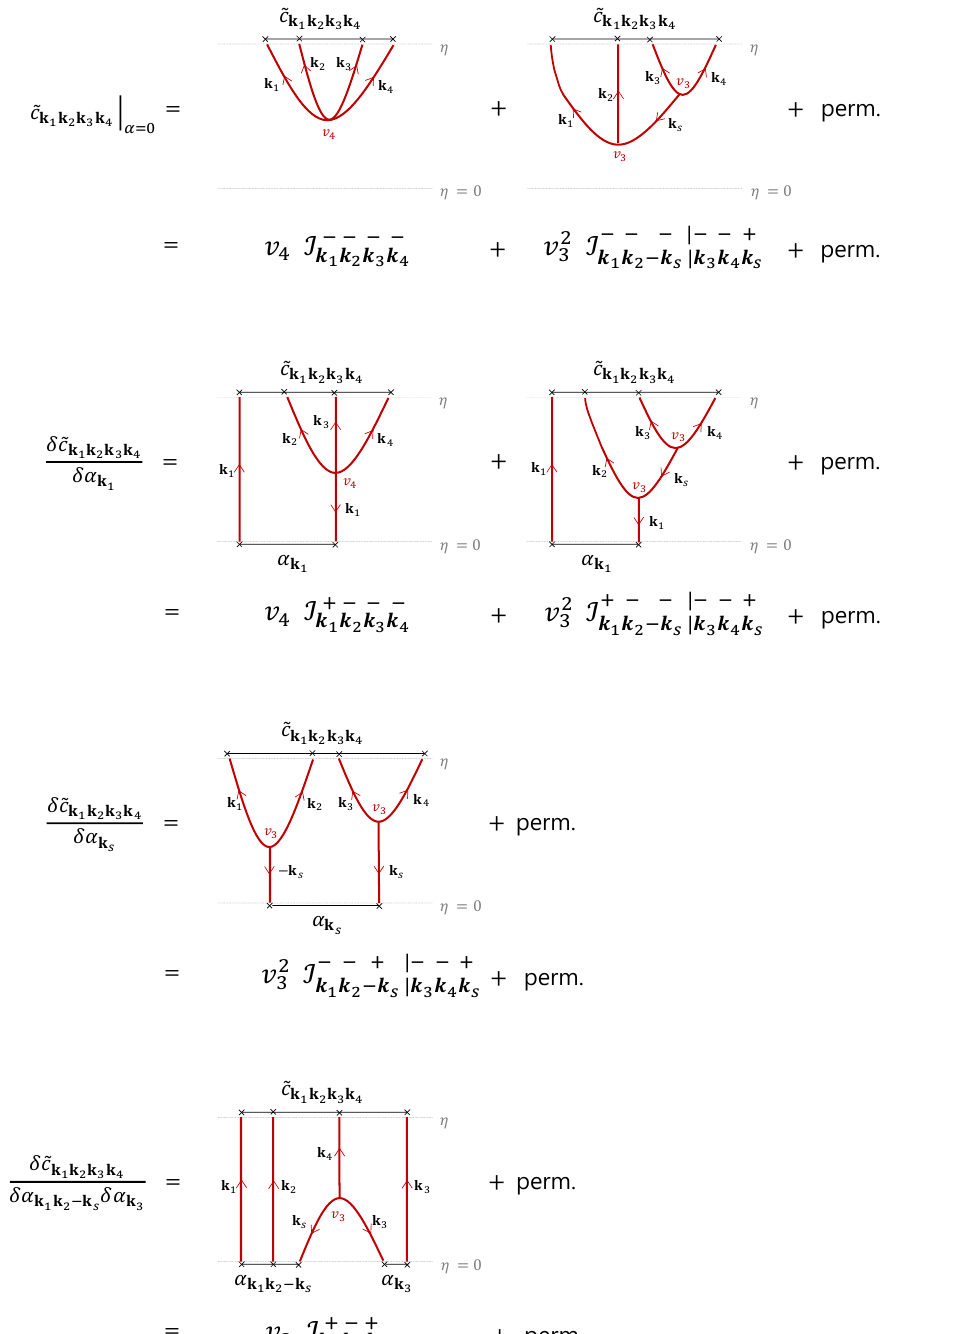
( η ) and its depen- 1 k 2 k 3 k 4 at η = 0 1 ... k n